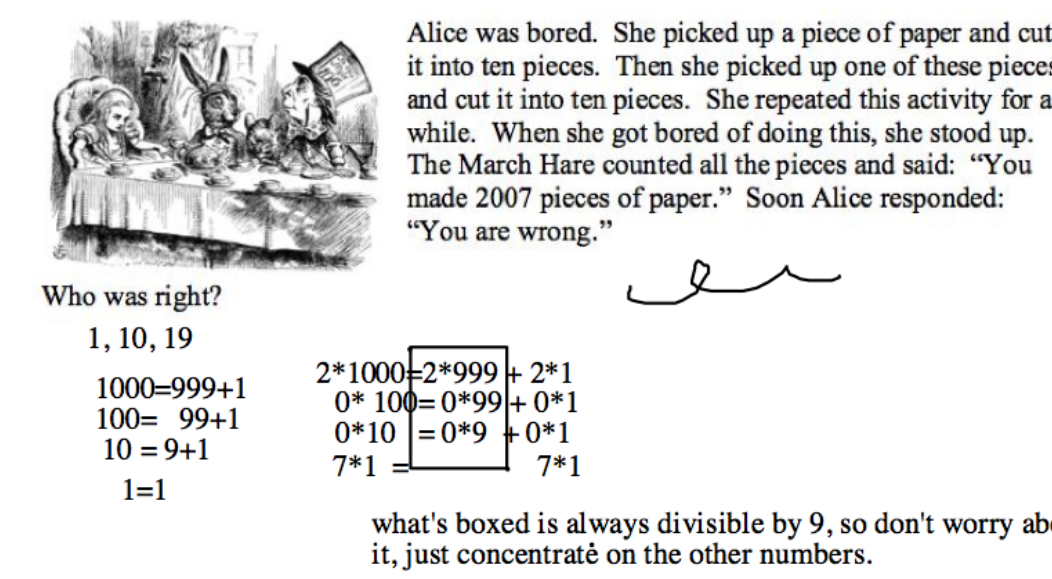
Figure 2 . The mathematics problem in